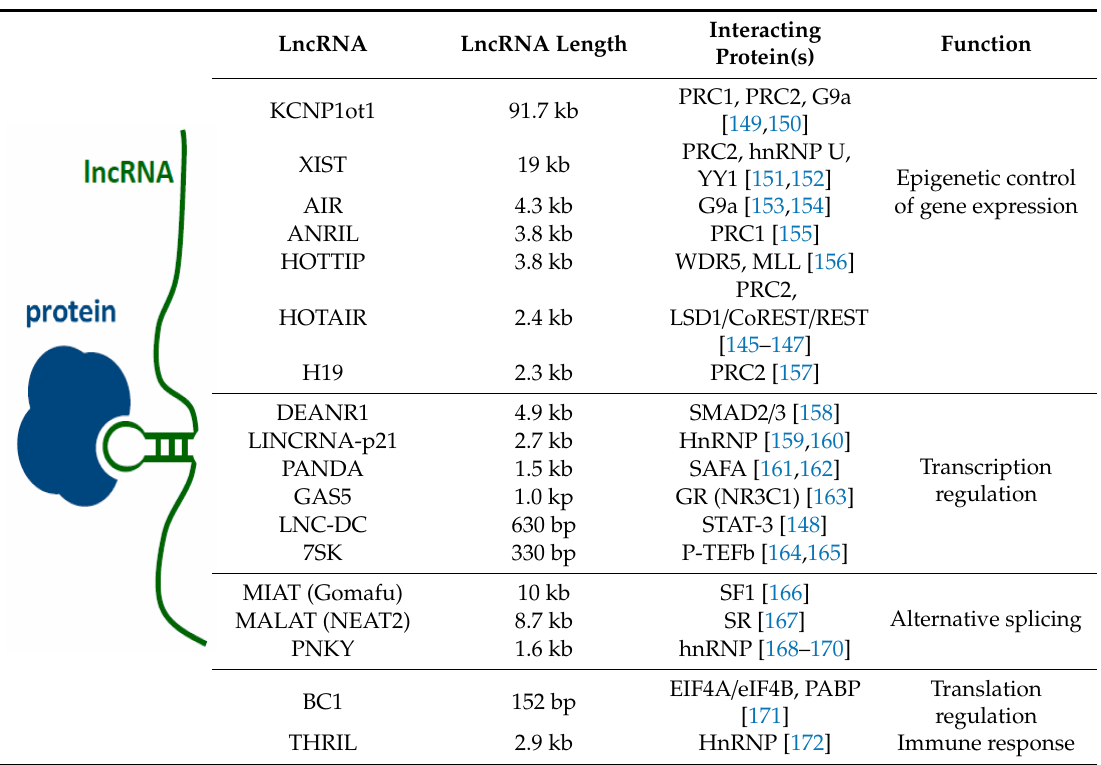
Table 5. lncRNA-protein complexes involved in the regulation of cellular